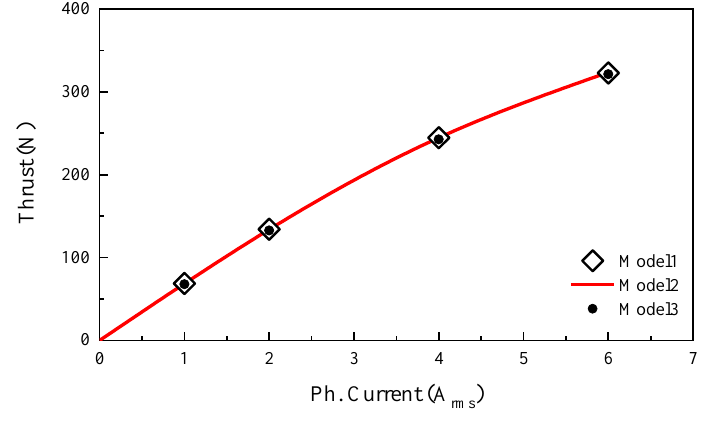
Figure 9. No-load phase back-EMF at 1.0 m/s.